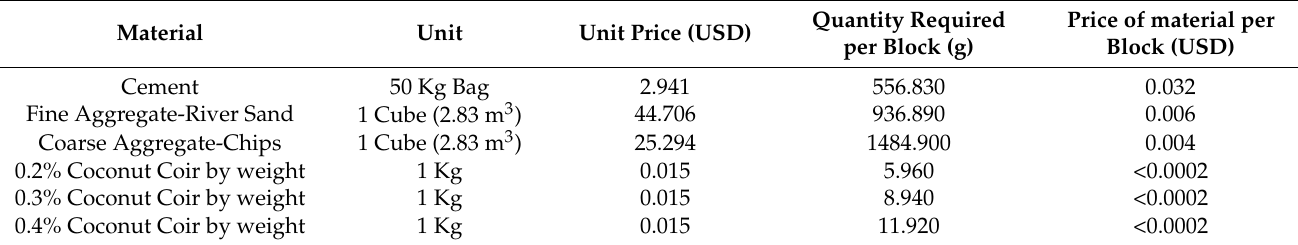
Table 6. Cost Analysis per CCF-based IPB (200 × 100 × 60